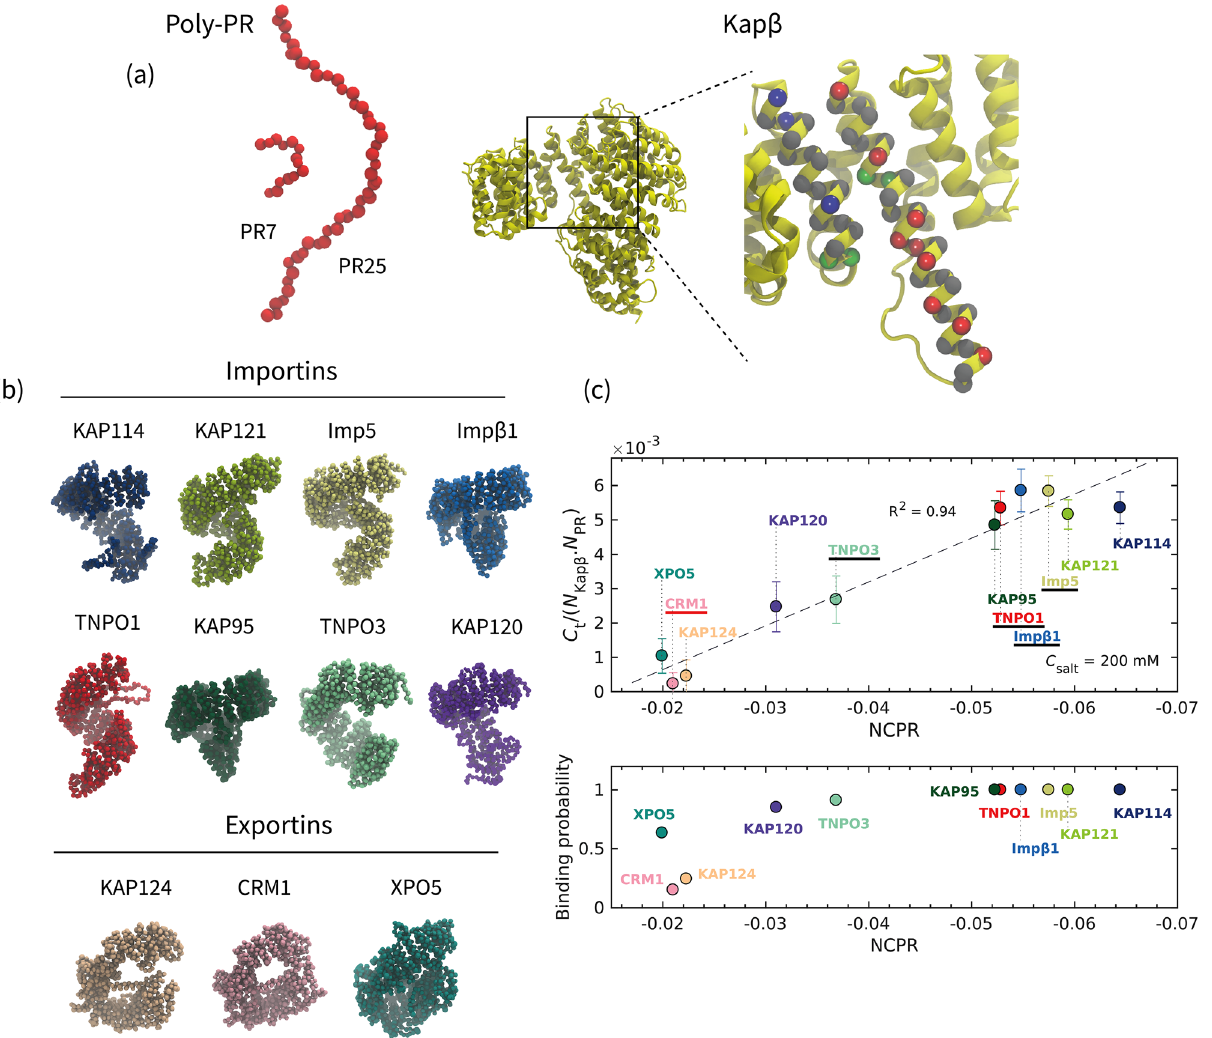
Figure 1. Coarse-grained modeling shows the importance of electrostatic interactions for the binding between poly-PR and Kapβs. ( a ) (Left panel) 1-bead-per-amino-acid (1BPA) representation of poly-PR with 7 and 25 repeat units. Both Proline and Arginine residues are shown in red. (Right panel) Our 1BPA approach to create coarse-grained (CG) models for Kapβs. The CG beads are placed at the location of α-carbon atoms, here shown for two α-helices of impβ1 on top of the crystal structure. Red, blue, and green beads correspond to negatively- charged residues (D and E), positively-charged residues (R and K), and residues with aromatic rings (F, Y, and W), respectively. Other residues are shown with grey beads. The all-atom crystal structure is depicted in yellow using the New Cartoon representation in VMD. ( b ) 1BPA representation of the various Kapβs modeled in the current study that serve either as importin or exportin. Importins have superhelical structures whereas exportins have a more ring-like structure in case of KAP124 and CRM1, and U-shaped structure in case of XPO5. The crystal structures used to make the CG models are listed in Table S3. ( c ) (Top panel) The time- averaged number of contacts C t between PR25 and Kapβs plotted against the net charge per residue (NCPR) of Kapβs at a monovalent salt concentration C salt of 200 mM. The values on the vertical axis are normalized by the sequence length of the importins/exportins ( N Kap β ) and the sequence length of poly-PR ( N PR ). The NCPR values on the horizontal axis is calculated based on the sequence lengths and amino acid compositions of the Kapβ models listed in Table S3 (column 6) and Table S5. Among the selected Kapβs, the importins Imp5, Impβ1, TNPO1, TNPO3 (highlighted with a horizontal black line) have been shown to directly bind to PR25 in in vitro experiments 19 . However, no binding has been observed for CRM1 (highlighted with a horizontal red line) in vitro experiments performed at the same monovalent salt concentration 19 . A linear correlation can be seen between the normalized C t and the negative NCPR. The dashed line shows a linear fit. The error bars are half of the standard deviation (see the SI for details). (Bottom panel) The PR25-Kapβs binding probability P b plotted against NCPR of Kapβs at C salt = 200